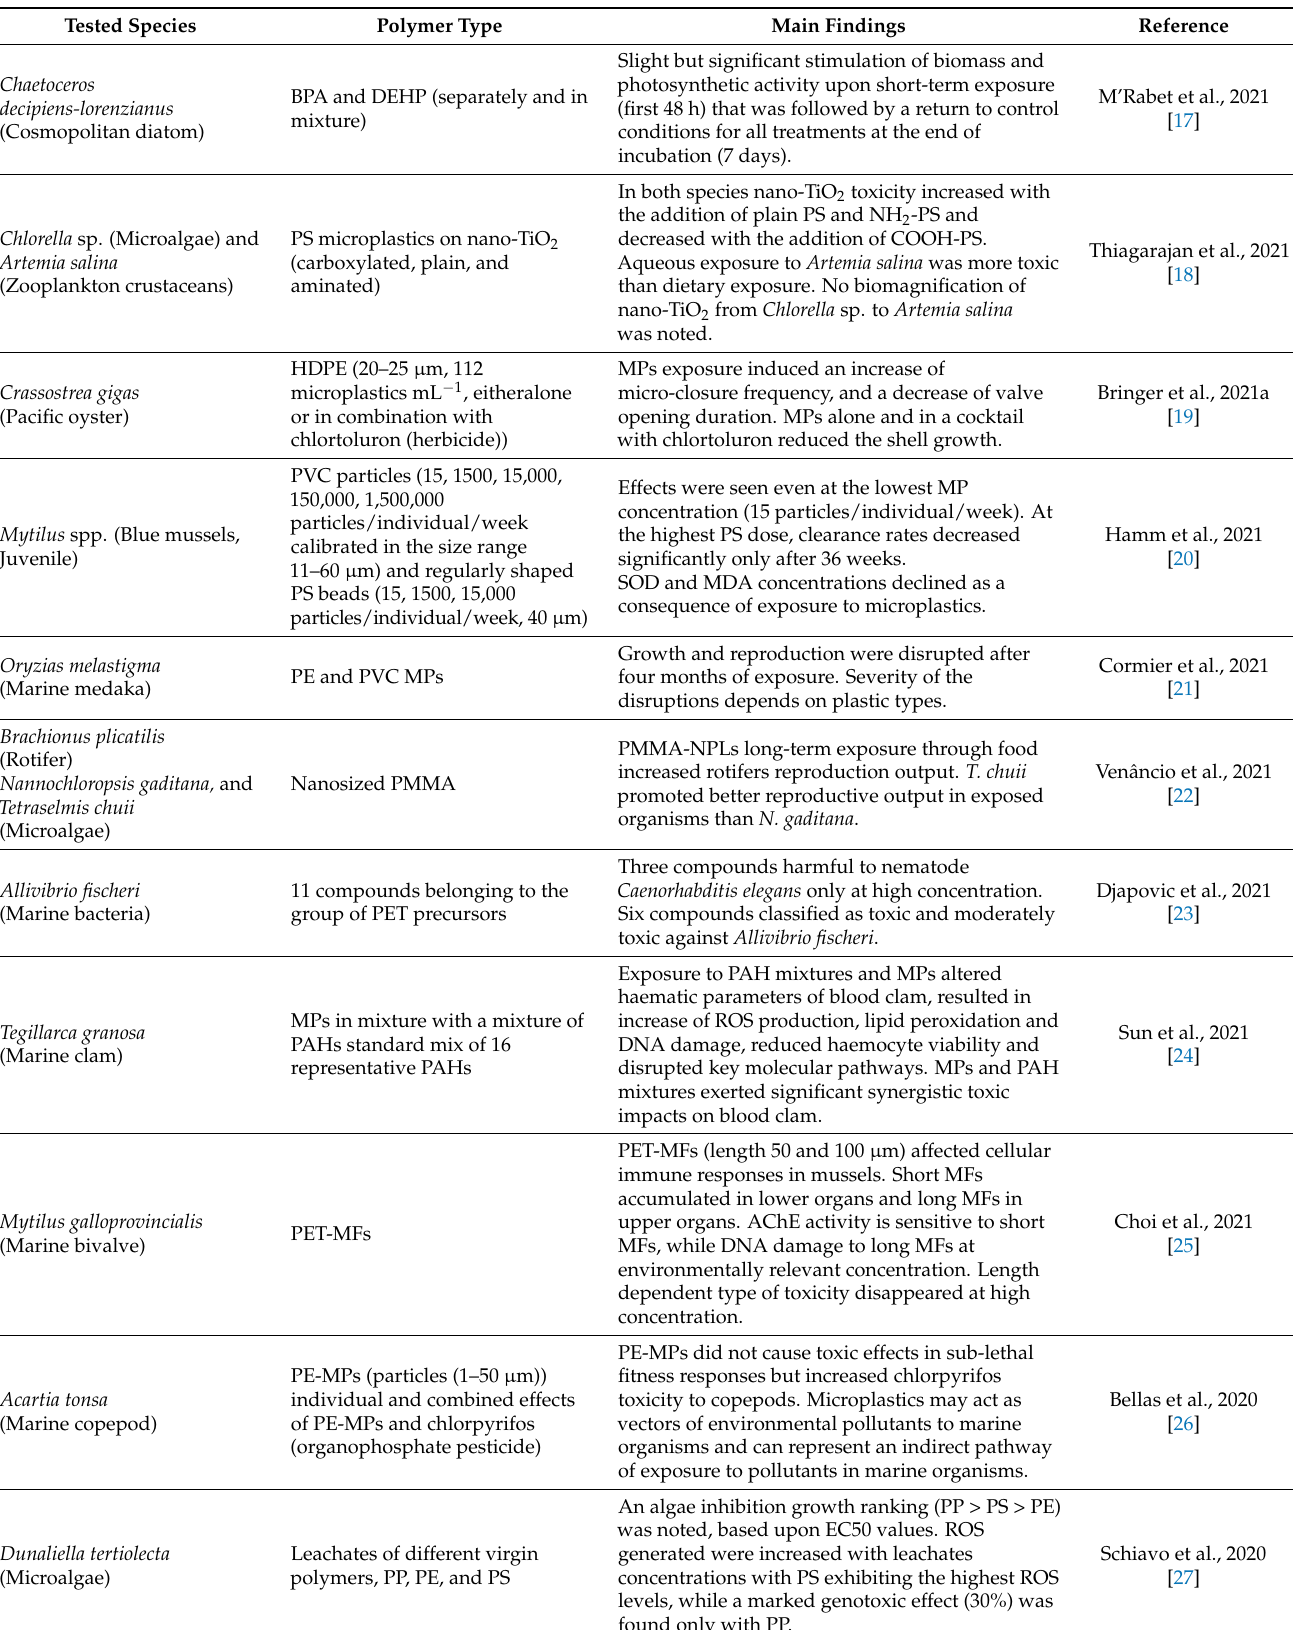
Table 1. Selected studies evaluating the toxicity of MPs, NPs and plastic-derived chemicals on marine plant and animal